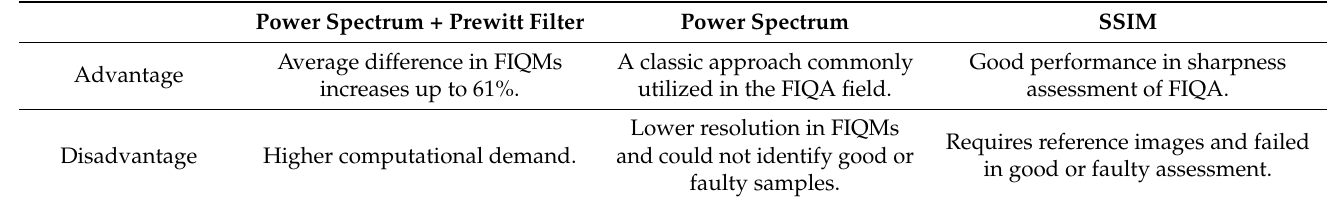
Table 2. Advantages and disadvantages of the proposed and conventional algorithm.